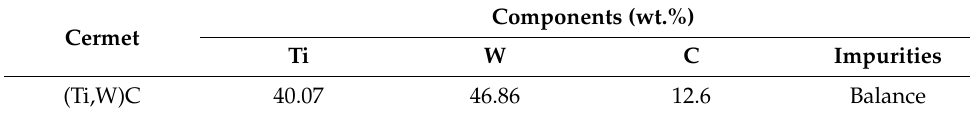
Table 2. Composition of raw material powder (wt.%).